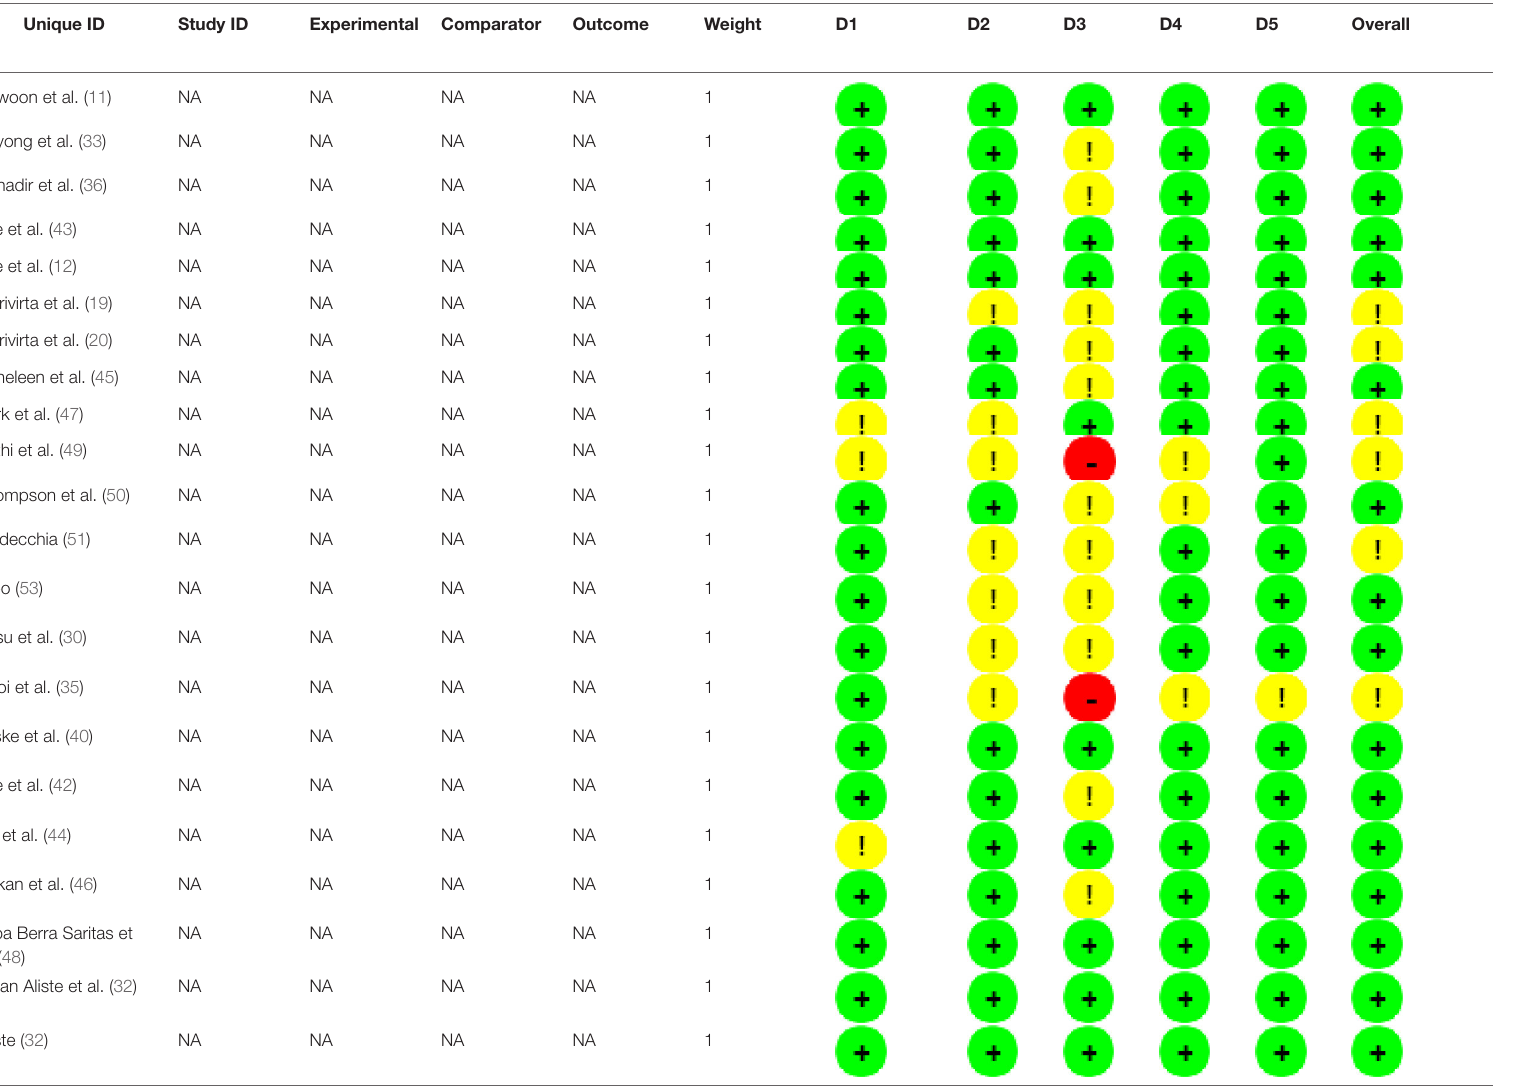
TABLE 3 | Quality assessment